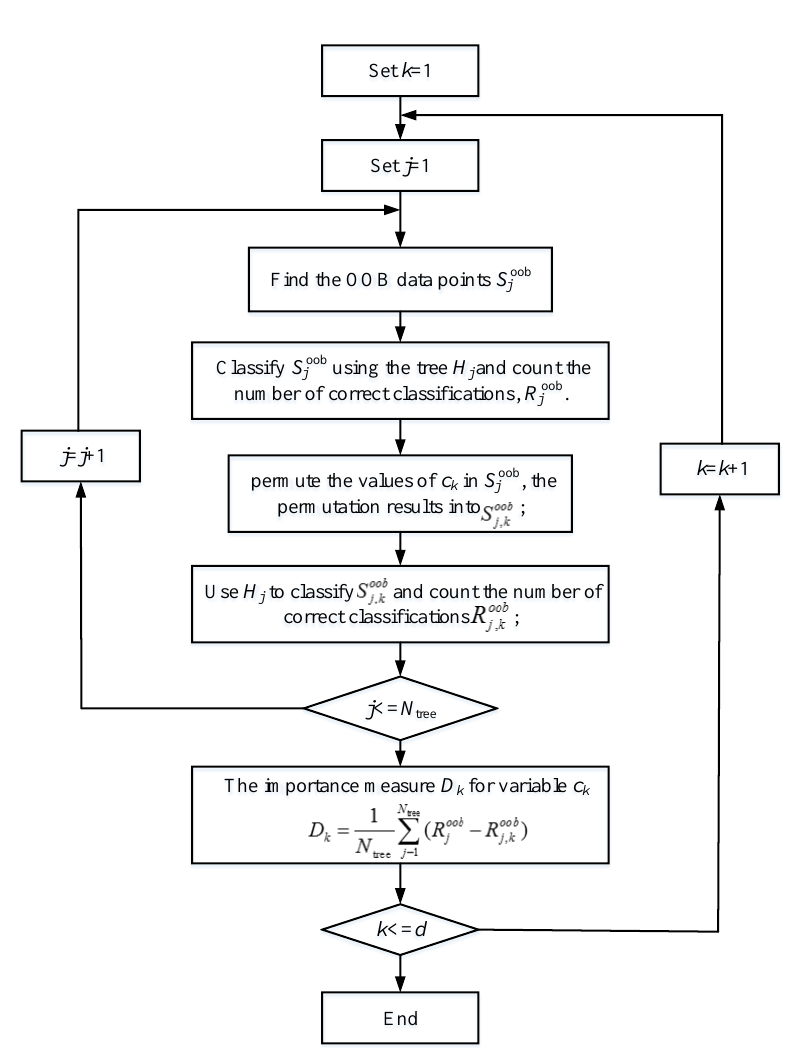
Figure 9. The process of analyzing the importance of feature based on random forest algorithm.